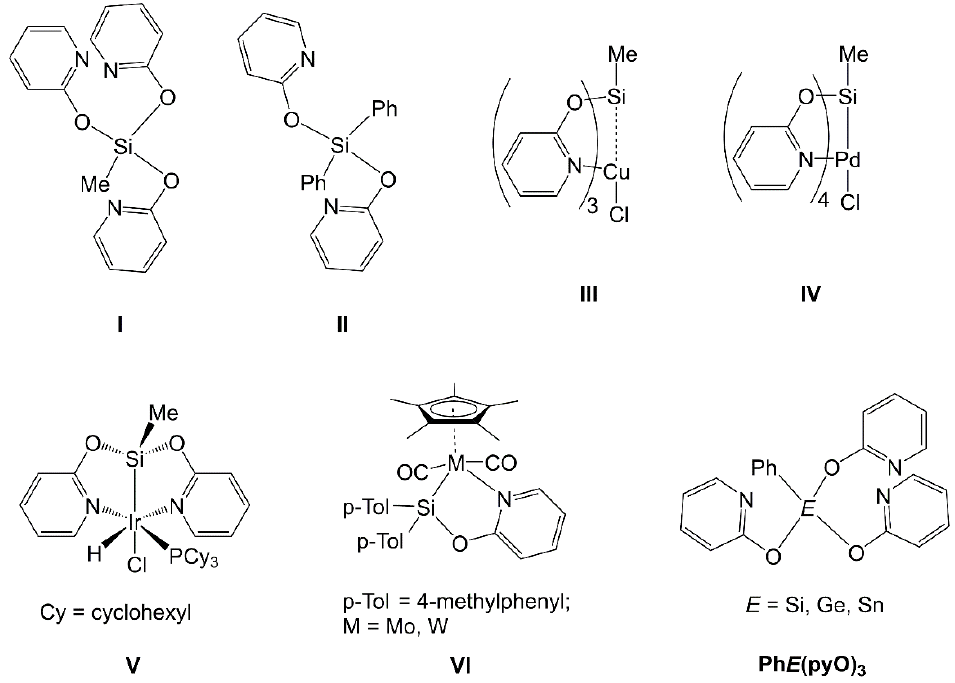
Figure 1. Selected pyridine-2-olate compounds of silicon with remote N ··· Si coordination ( I , II ), with hypercoordinate Si atom featuring a metal atom in the coordination sphere ( III , IV ) and with tetracoordinate Si bound to a transition metal atom ( V , VI ) as well as a generic representation of the compounds ( Ph E (pyO) 3 ) under investigation in this paper.